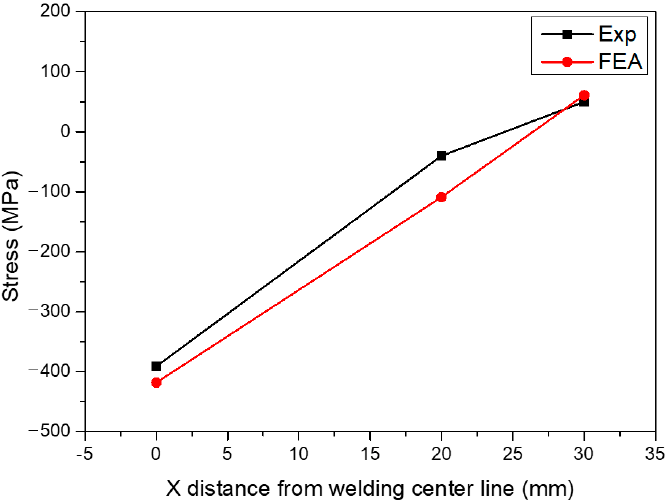
Figure 16. Validation between FEA and experiment.